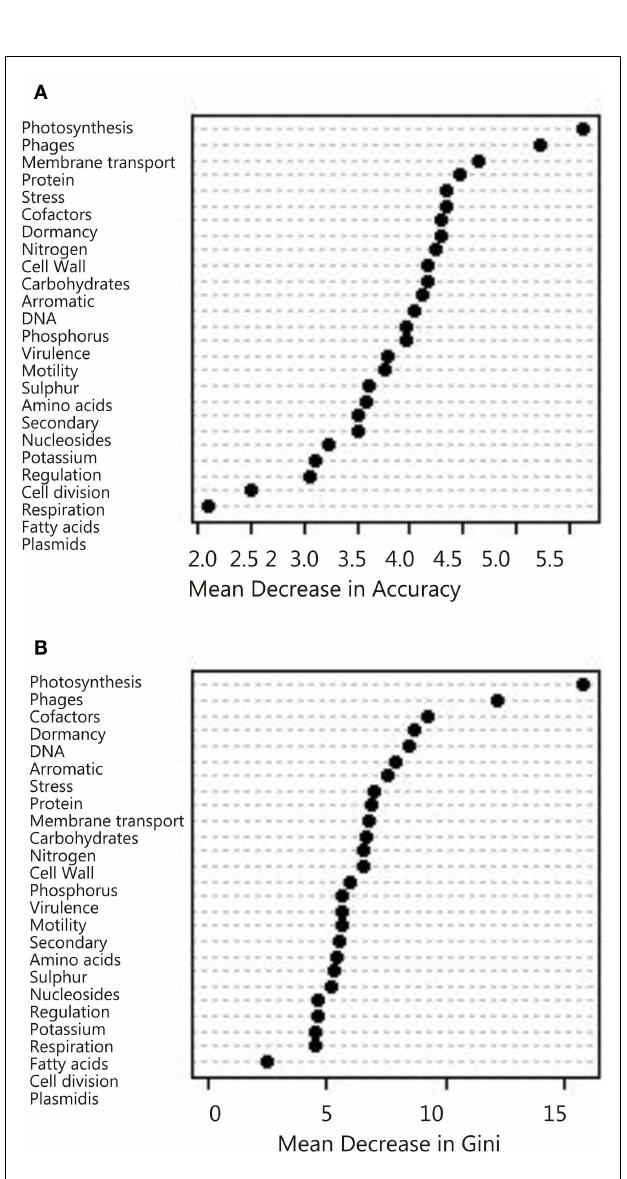
FIGURE 5 |Variable importance determined by the random forest analysis using mean decrease in (A)Accuracy and (B)